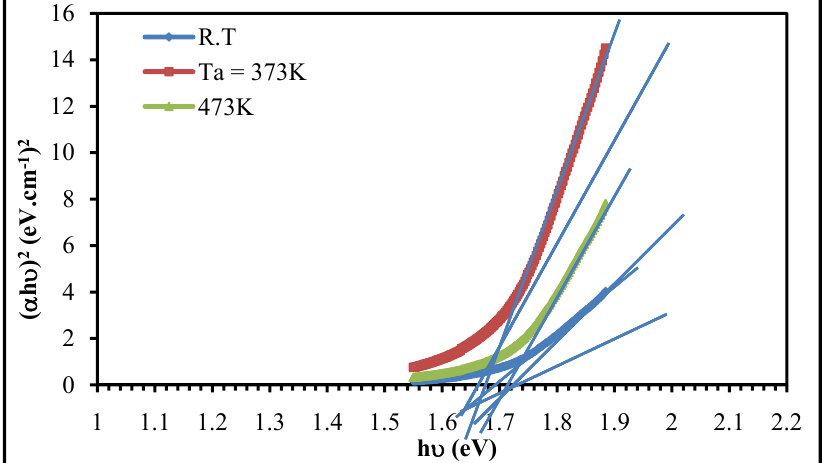
Fig. 4: ( α h ʋ ) 2 versus photon energy of incident radiation for as-deposited and annealed NiPcTs thin films (Q-band).